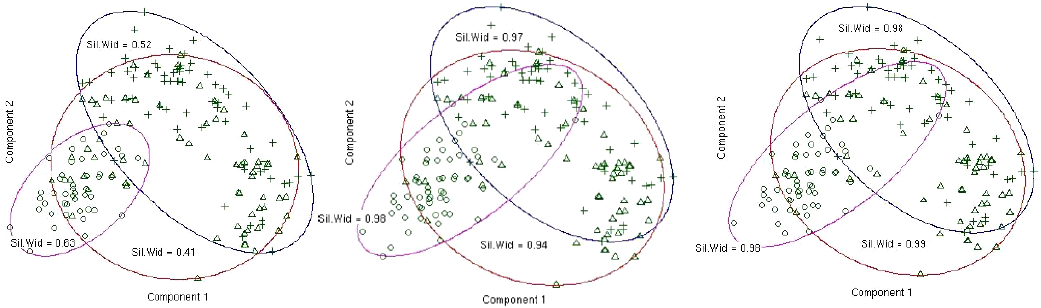
Fig. 17. Wine Dataset: (i) Result by KFCM (ii) Result by KEFCM wd (iii) Result by KFCM nt .